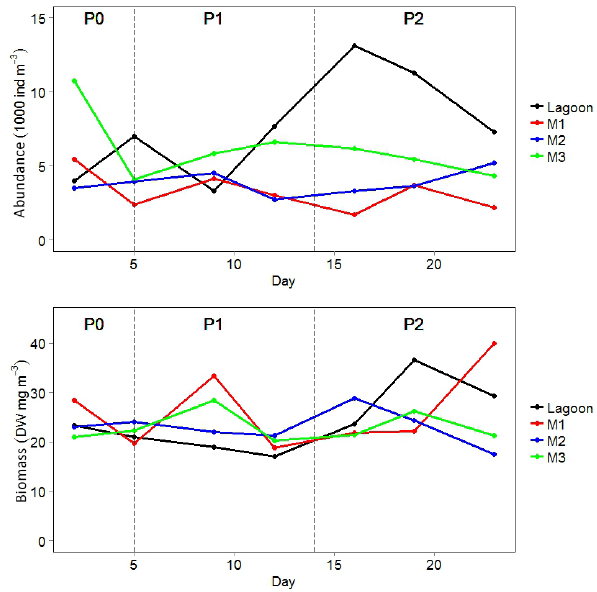
Figure 2. Zooplankton abundance (indm − 3 ; above) and biomass (mgDWm − 3 ; below) over the 23-day VAHINE experiment (13 January to 4 February 2013) for the three VAHINE meso- cosms (M1–3) and the lagoon waters. P0, P1, and P2 refer to the pre-phosphorous fertilization, DDA-dominated, and UCYN-C- dominated periods of the experiment,